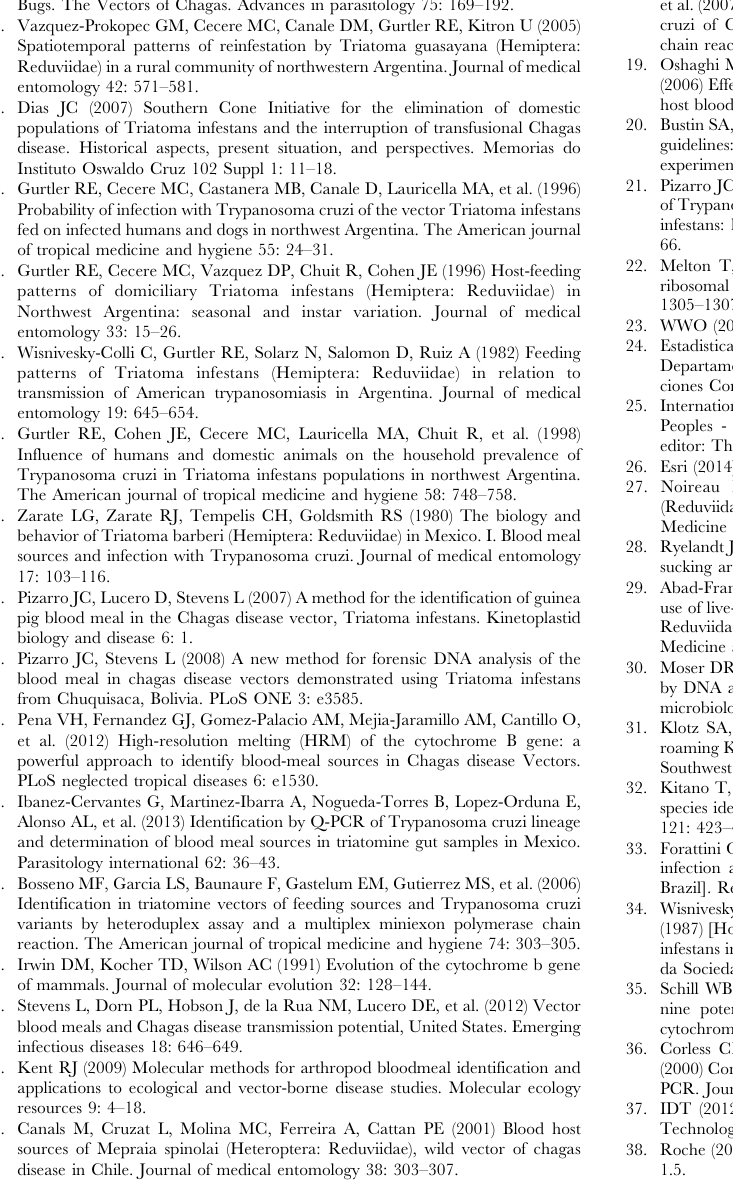
Table S2 Summary of qPCR and cloning blood meal assays of sylvatic Triatoma guasayana , showing that taxa identified by cloning were also always detected by qPCR; however, taxa identified by qPCR were not always identified by cloning. The Cp (crossing point) and sequence ID of the qPCR product or cloned DNA are shown; sequence IDs are based on 100% match in a BLAST search of . 100